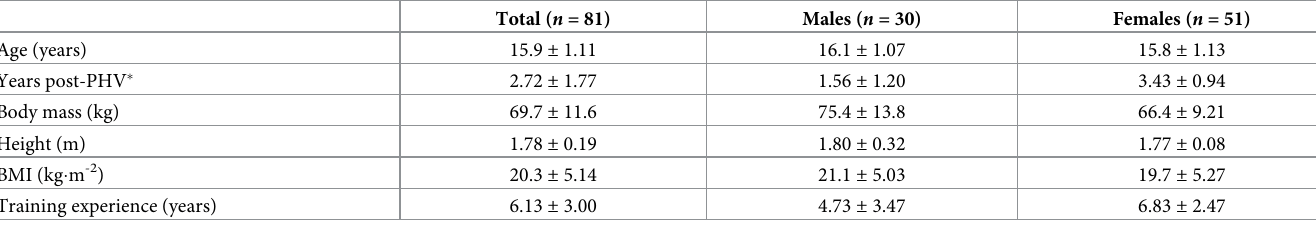
Table 1. Participants characteristics as total and split by